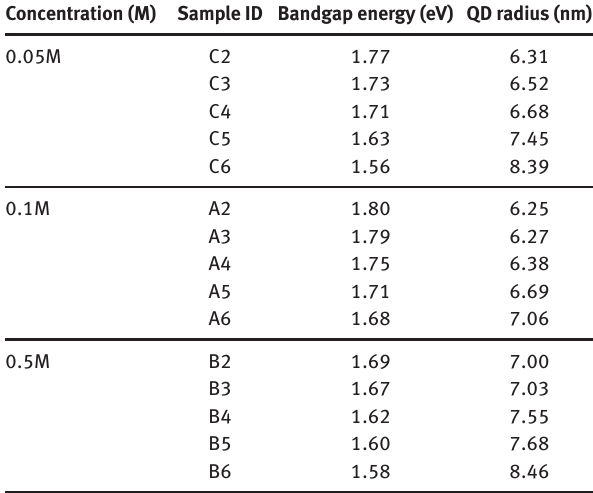
Table 3: SnS QD size and its corresponding bandgap